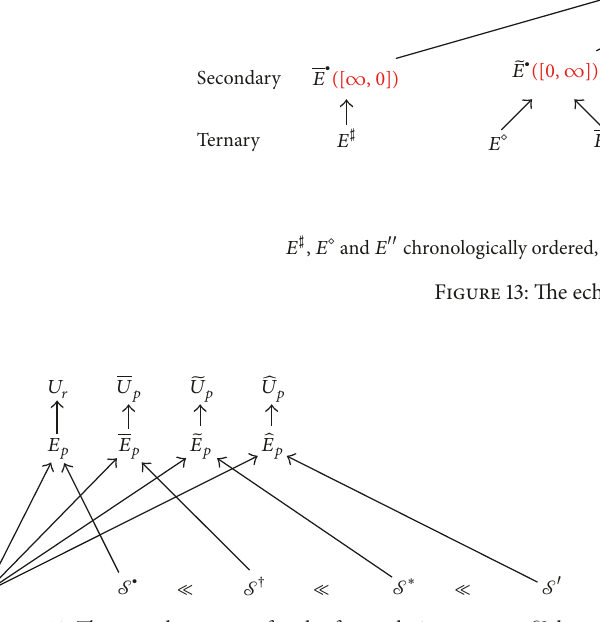
Figure 14: The causal structure for the four echoing systems E ch, E ch, ̃ E ch, and ̂ E ch with the event 𝑒 . The chronological order between S ∙ , S † , S ∗ , and S 耠 belonging to W S can be different.